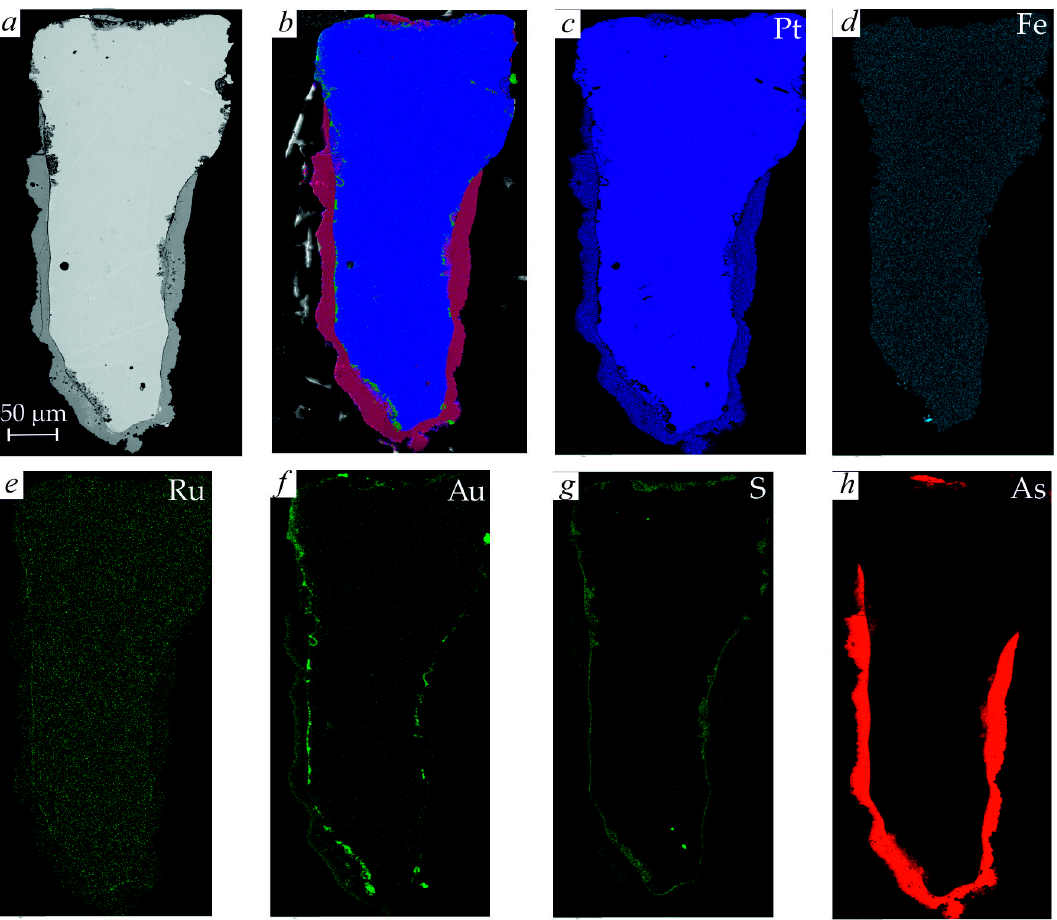
Figure 5. Backscattered-electron image (BSE) ( a ) and element distribution maps ( b —polyelement; c —Pt; d —Fe; e —Ru; f — Au; g —S; h —As) in the grain No. 3 (see Figure 4) platinum nugget. Table 7. The composition of the core in grain No. 3 (Figure 4) and its inclusions and micro lamellae (at.%), determined by the SEM-EDS method.